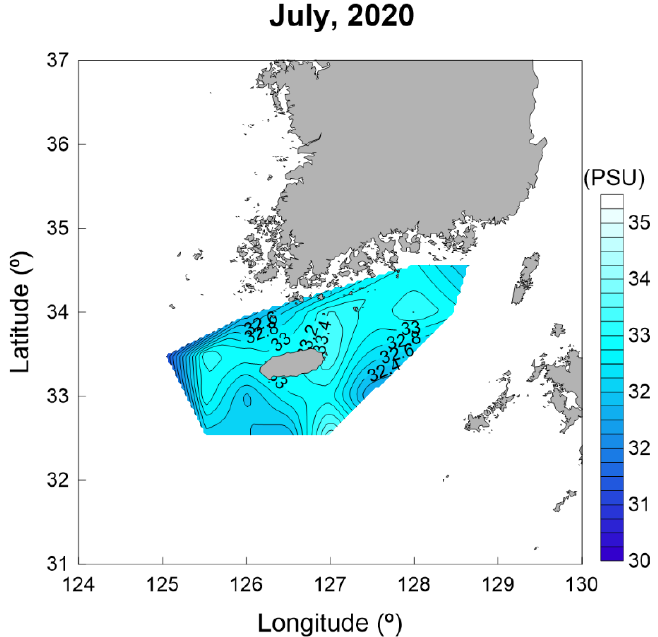
Figure 12. Distribution of salinity in the major swimming layers in the Southern Sea and Jeju coastal waters.